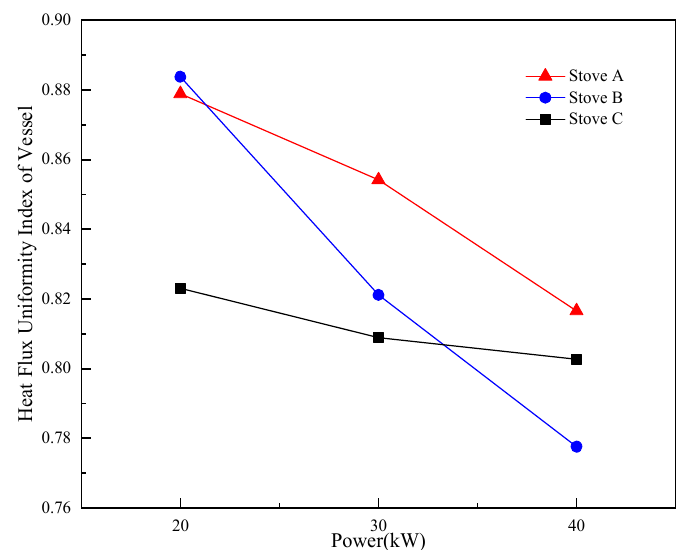
Figure 9. Heat flux uniformity index of the three stoves at different power rates.